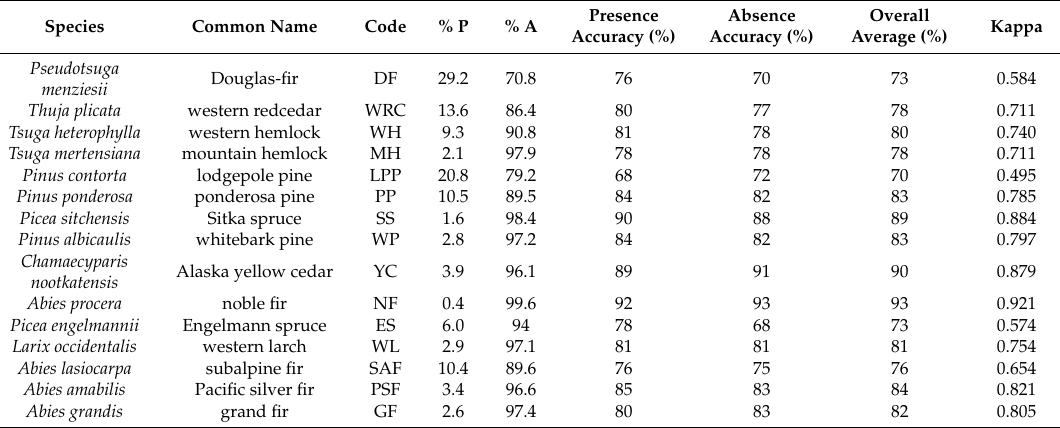
Table 1. Scientific and common names, as well as the proportion of plots with the presence and absence of the species correctly predicted across the Pacific Northwest region. P indicates Presensce, A;